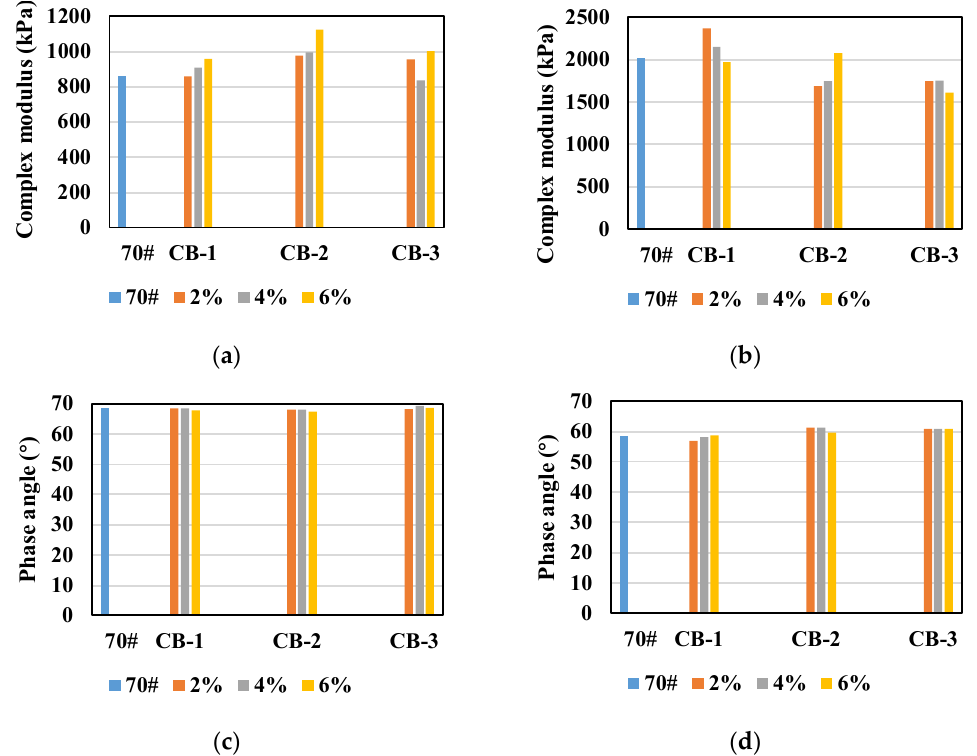
Figure 11. Comparison of unaged asphalt and asphalt after PAV aging: ( a , c ) unaged asphalt; ( b , d ) asphalt after PAV aging.